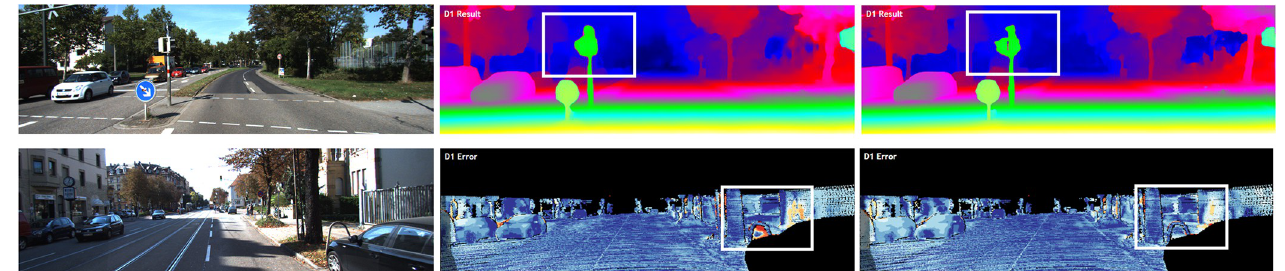
Fig 5. Results visualization and comparisons on KITTI 2015 [10]. Left column: the input left image. Middle column: predicted color disparity and error map by GWC-Net. Right column: predicted color disparity and error map by PA-Net. As shown in the white boxes, PA-Net performance better than previous work in areas with large parallax such as the iron railing in front of the car.